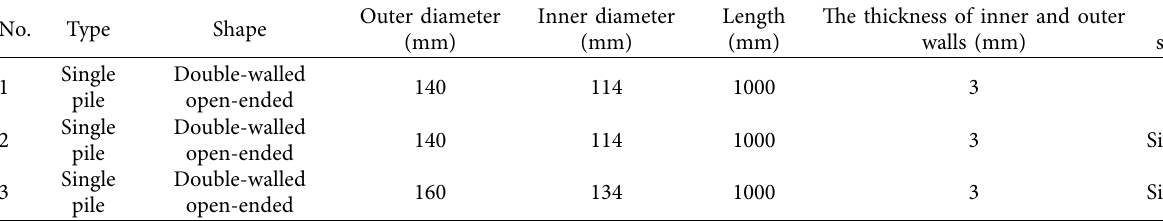
Table 1: Single-pile static test.